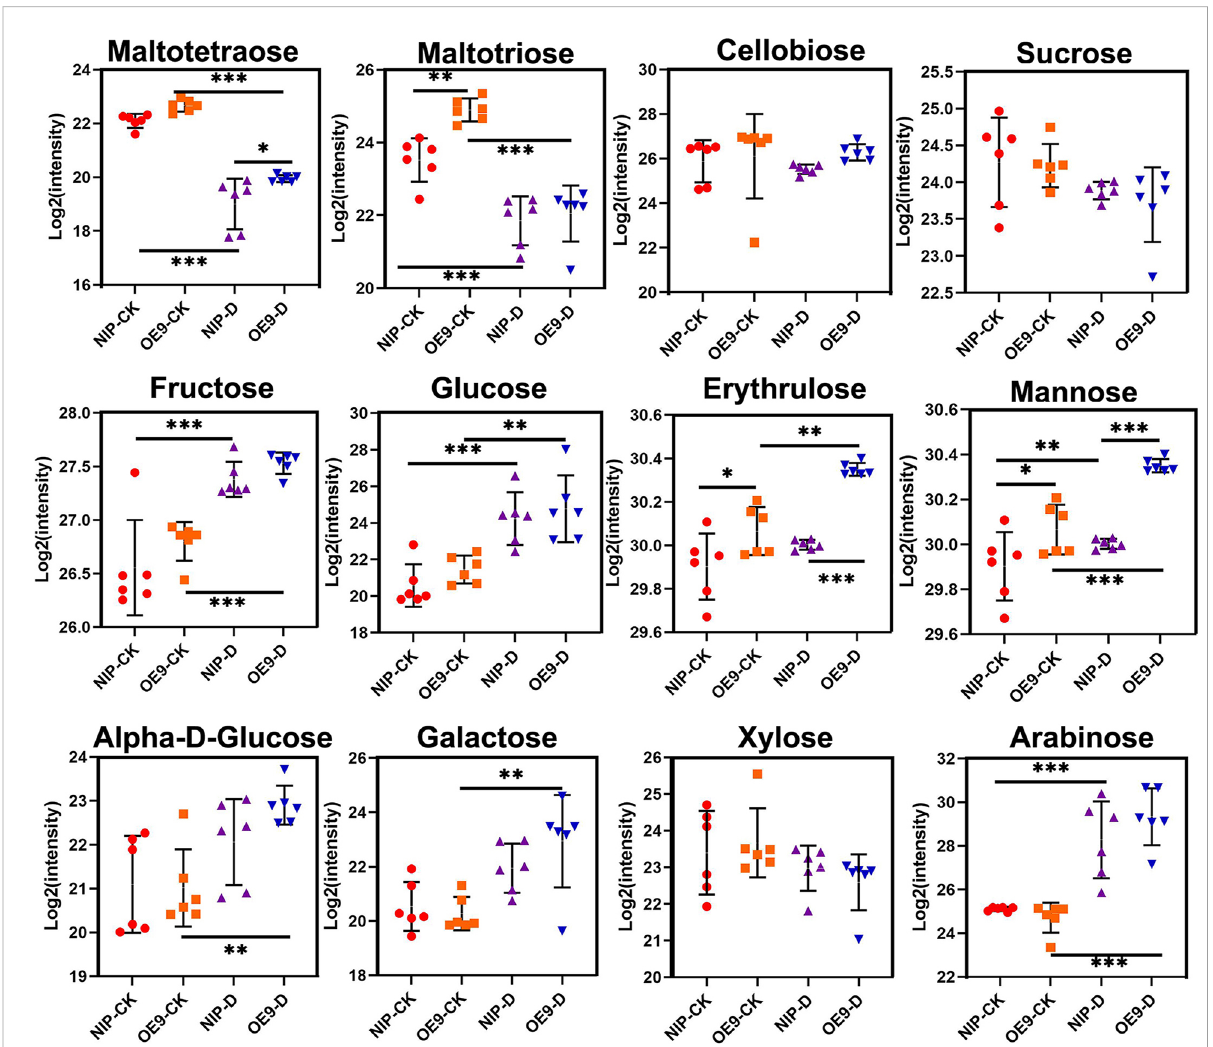
FIGURE 4 Sugar content in the control and drought treatment with metabolomics analysis. Data are presented as mean ± SD of six independent experiments, and signi fi cant differences between NIP-CK and OE9-CK/NIP-D or OE9-D and OE9-CK/NIP-D plants according to one-way ANOVA are indicated by asterisks. Asterisks indicate signi fi cance (*p < 0.05, **p < 0.01, ***p < 0.001). CK: NIP or OE materials without drought treatment. OE9: OsCIPK17 -OE9. D: drought treatment (with 20% PEG treatment of 3-week-old rice seedlings for 5